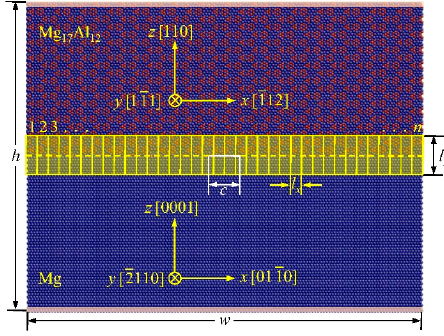
Figure 1. Simulation model of the Mg/Mg 17 Al 12 bimaterial.